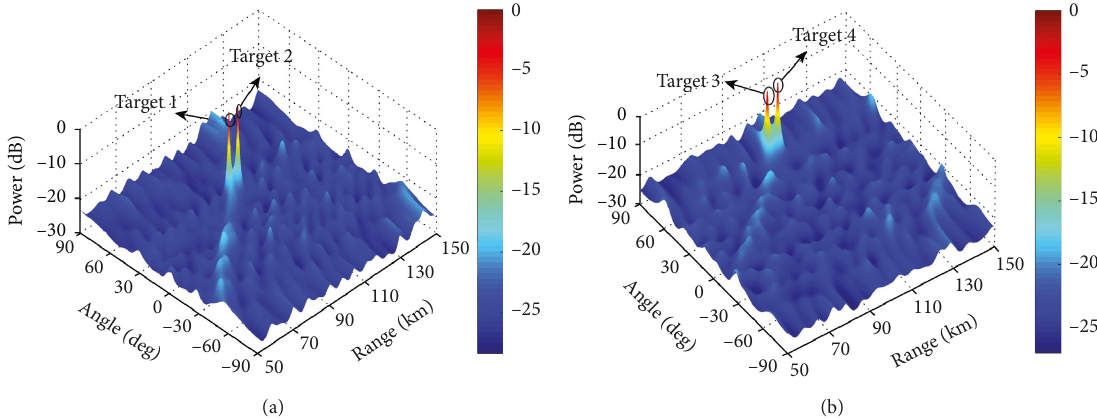
Figure 8: MUSIC spectra by using the proposed scheme for (a) target 1 (100km, 30 ° ) and target 2 (105km, 30 ° ) with K (b) target 3 (100km, 60 ° ) and target 4 (105km, 60 ° ) with K 1